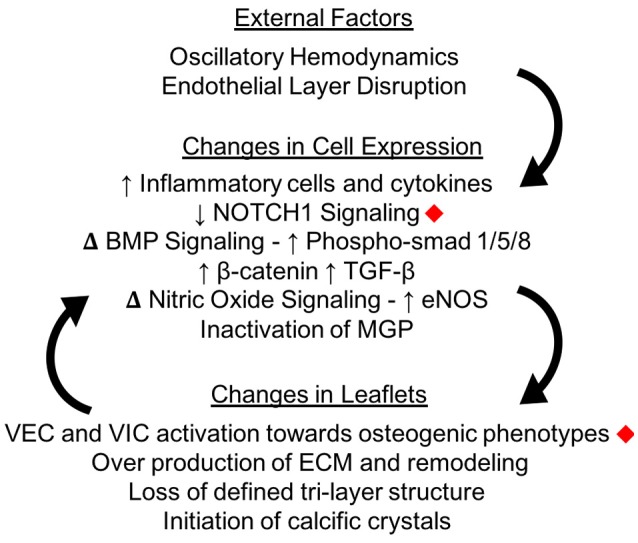
Calcification changes cell expression in the aortic valve. The oscillatory shear stresses experienced by VECs on the fibrosa side of the valve can lead to endothelial layer disruption as well as specific changes in cellular pathway expressions. Changes in cellular expression can change the macro structure of the valve leaflets, which creates a positive feedback loop instigating calcification. Changes marked with red diamonds have been expressly linked to mechanical shear stresses in the aortic valve.